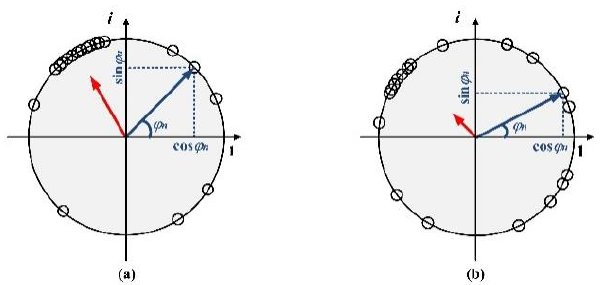
Figure 2. Schematic diagram of phase angle distribution consistency represented by vector coherence factor. ( a ) Centralized distribution and ( b ) random distribution.